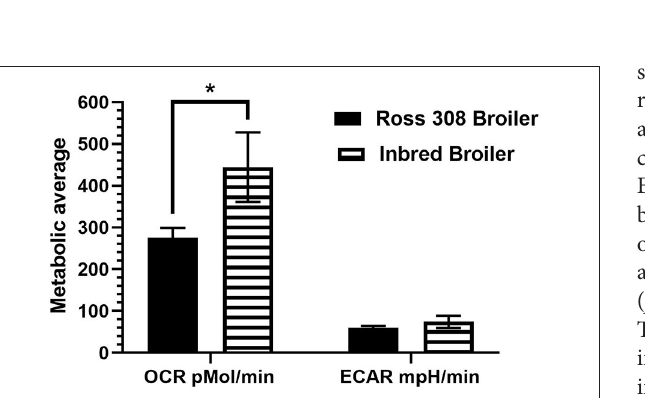
FIGURE 6 | Baseline metabolic comparison of OCR and ECAR analyzed between two broiler genetic lines of different ages: Ross 308 broilers (aged 5–7 weeks) and inbred broilers (aged 32 weeks) using PBMCs within the Seahorse Xfe24 Analyzer with the main effect of bird age/genetic line. All data are presented as LSMeans 1 (SEM). 1 Asterisk indicates a difference in LSMeans approaching statistical significance ( p <